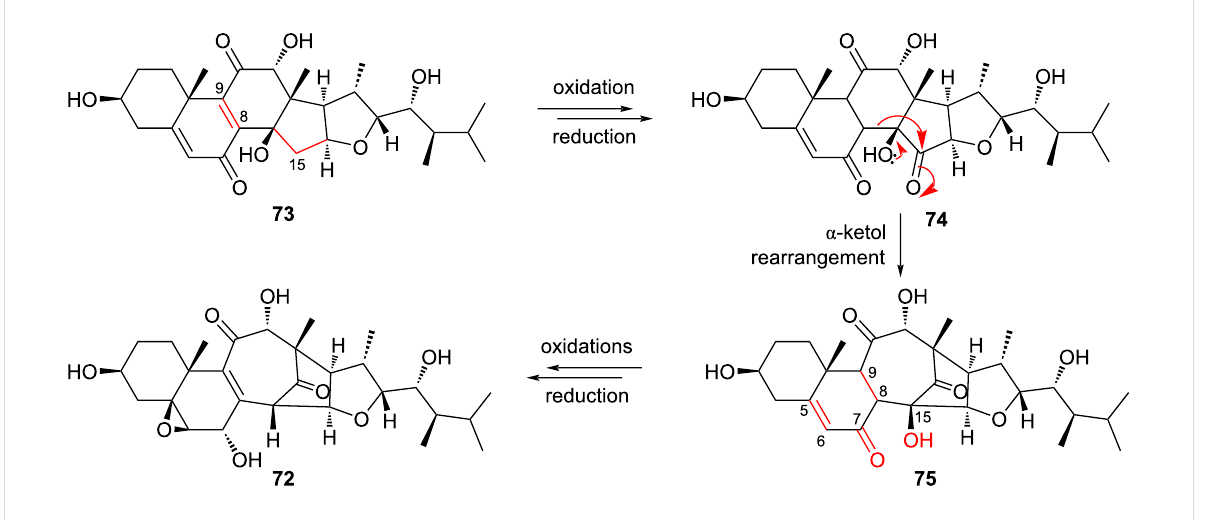
Figure 15: The conversion of asperfloroid ( 73 ) to asperflotone ( 72 ), featuring the ring-expanding α -ketol rearrangement of 74 to form 75 .